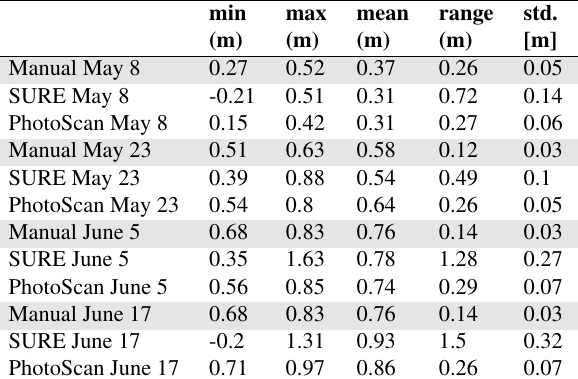
Figure 6. Regressions of mean CSM-derived plant height and manually measured plant height, evening acquisition